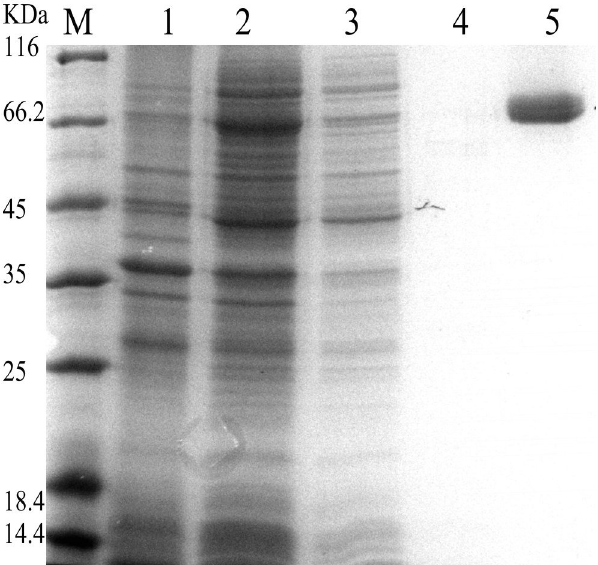
Fig 2. SDS-PAGE analysis of the recombinant TreS. Lane M, protein molecular weight markers; lane 1, the crude extract of the recombinant E . coli BL21 harboring pETDuet-1; lane 2, the crude extract of the recombinant E . coli BL21 harboring pETDuet- treS ; lane 3, the sample eluted with 80% binding buffer and 20% elution buffer; lane 4, the sample eluted with 60% binding buffer and 40% elution buffer; lane 5, purified TreS eluted with 40% binding buffer and 60% elution buffer.